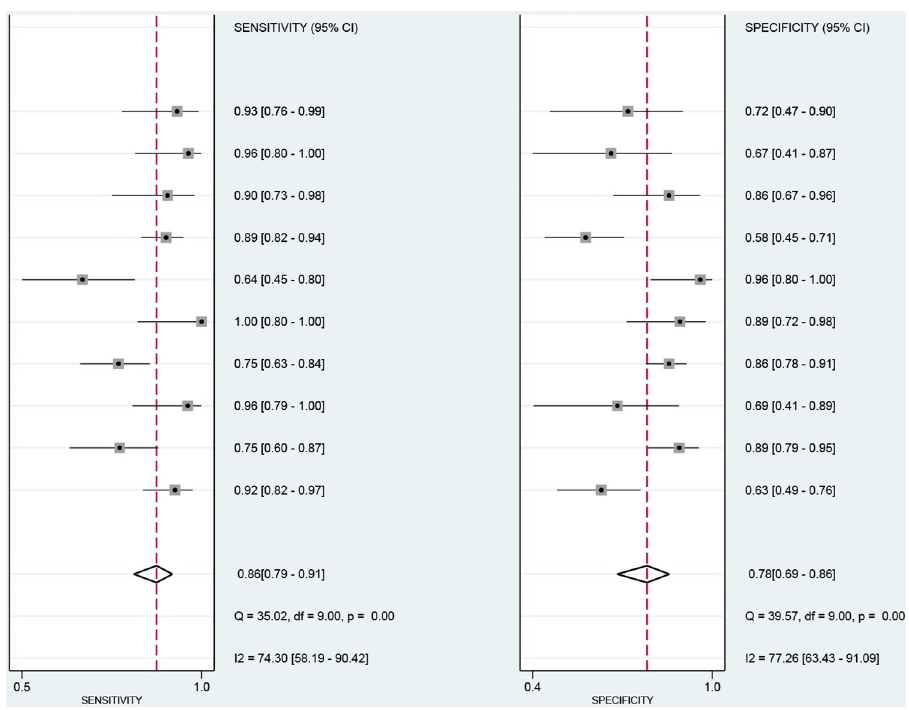
Fig 5. Forest plots of sensitivity and specificity of Serum creatinine in predicting mortality after paraquat poisoning. The diamond indicates the combined estimate from the included studies. https://doi.org/10.1371/journal.pone.0281897.g005 The sensitivity of blood creatinine to predict the prognosis of PQ poisoning was 0.86,